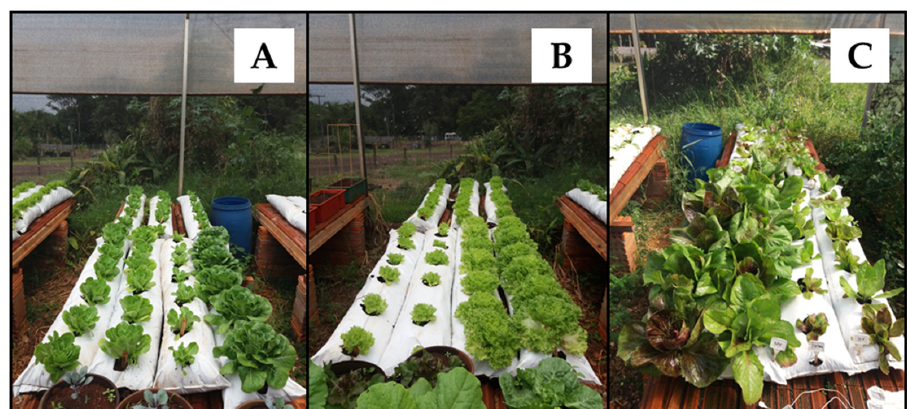
Figure 1. Leafy vegetable cultivated in horizontal grow-bag submitted to different concentrations of boiled chicken manure (BCM), bokashi, and mineral fertilization in a greenhouse. ( A ) Romaine